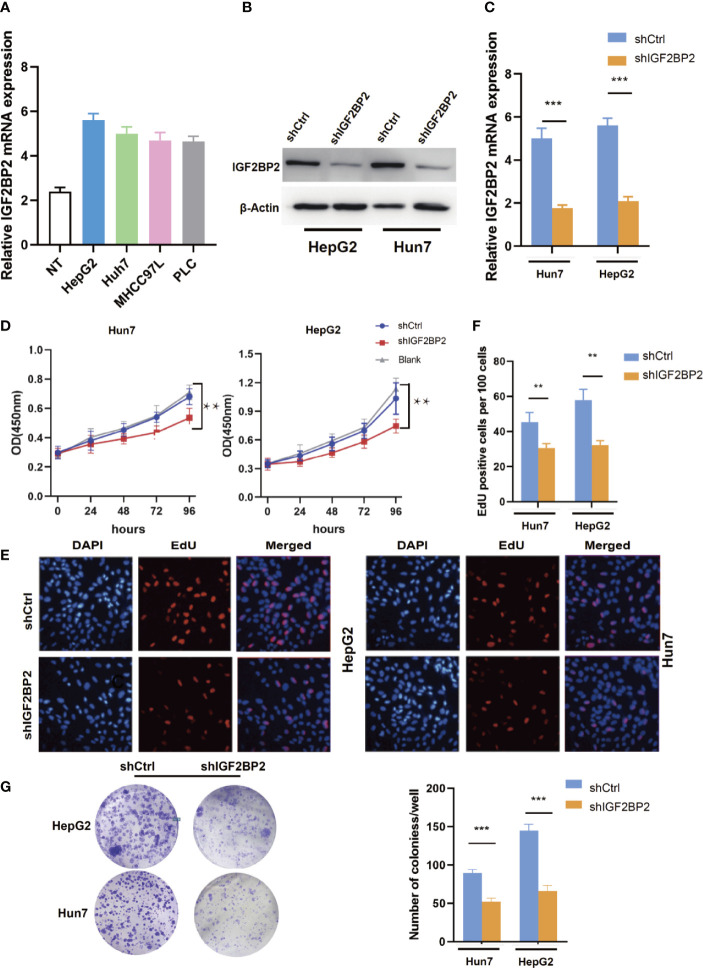
IGF2BP2 Promotes HCC Cells Tumorigenicity in vitro. (A) The expression of IGF2BP2 mRNA in HCC cells was determined using qRT-PCR (The experiment was repeated three times). (B, C) Expression level of IGF2BP2 knockdown efficiency in HepG2 and Hun7 cell lines was detected by western blot and qRT-PCR. (D) The influences of IGF2BP2 knockdown on cell proliferation were confirmed using the CCK-8 assay (**P < 0.01, Student’s t-test). (E, F) The influences of IGF2BP2 knockdown on cell proliferation were confirmed by EdU assay (**P < 0.01, Student’s t-test). (G) The representative picture of colony formation assay, and the quantification of colonies per well (***P < 0.001, Student’s t-test).